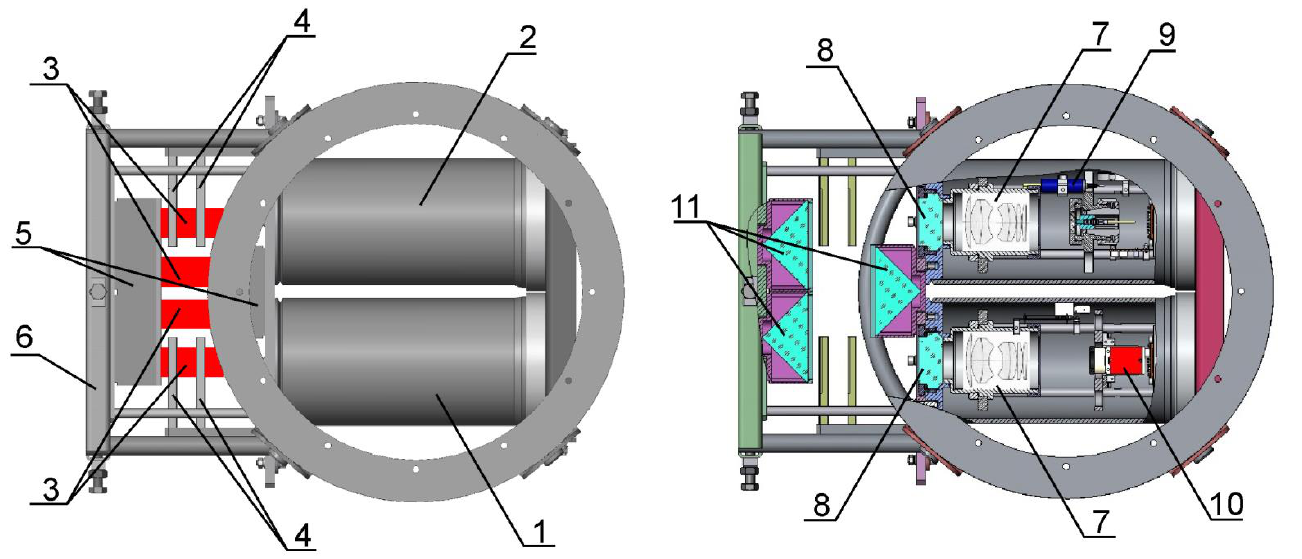
Figure 2. Horizontal version of the DHC: 1—recording module, 2—lighting module, 3—studied medium volume (working volume), 4—calibers (test objects for magnification calibration), 5—mirror-prism system to create a measuring channel in the medium (working volume), 6—submersible device frame, 7—35 KP-1.8/70 lens, 8—portholes, 9—laser-diode fiber module, 10—CMOS camera, 11—measuring channel prisms.